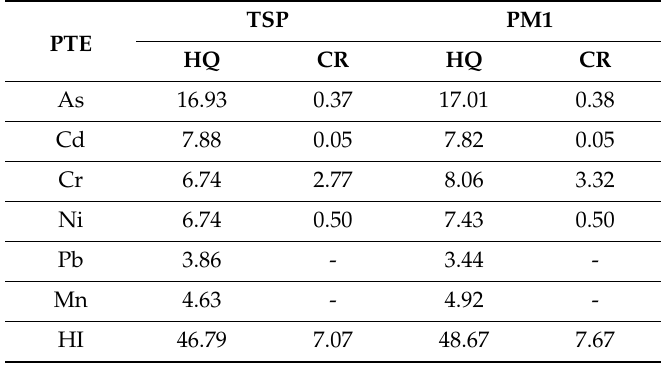
Table 7. Comparative results of non-carcinogenic (HQ) and carcinogenic risks (CR) due to human exposure to metals collected on TSP and PM1